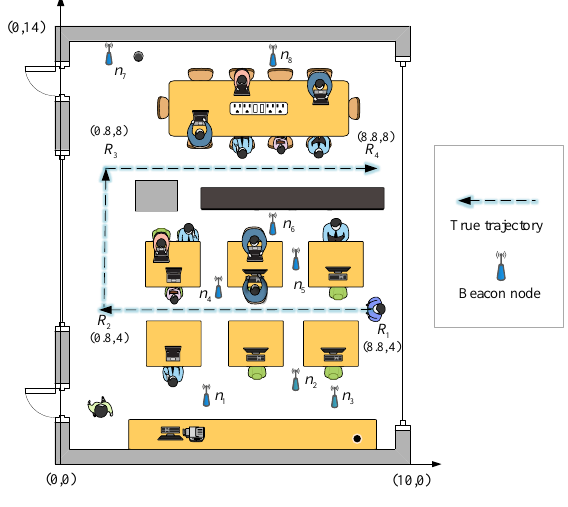
Figure 14. The experimental scene.